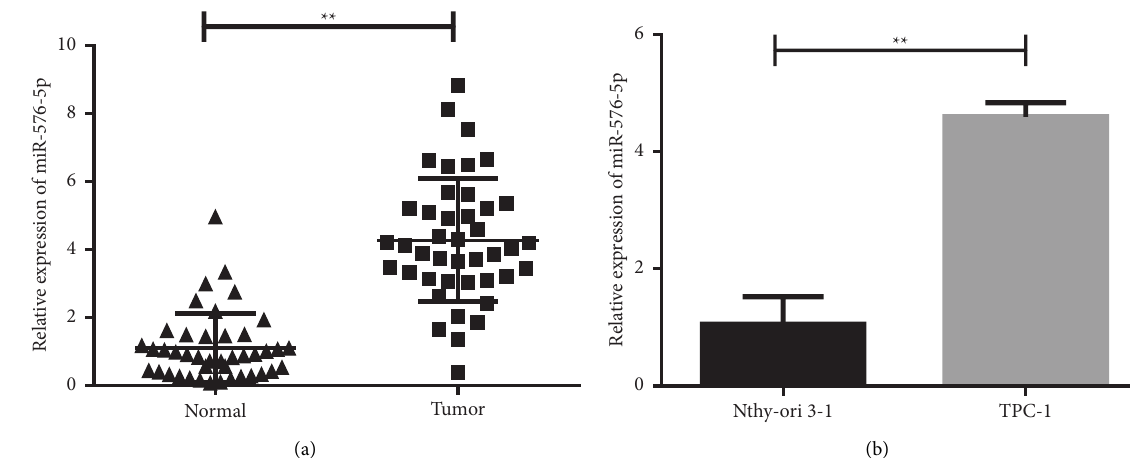
Figure 1: miR-576-5p was signifcantly upregulated in PTC tissues and TPC-1 cells. (a) Relative expression levels of miR-576-5p in PTC tissues and corresponding adjacent normal tissues were detected by RT-qPCR. (b) Relative expression levels of miR-576-5p in the PTC cell line TPC-1 and in the normal thyroid follicular epithelial cell line Nthy-ori 3-1 were detected by RT-qPCR. ∗∗ P < 0 . 01.